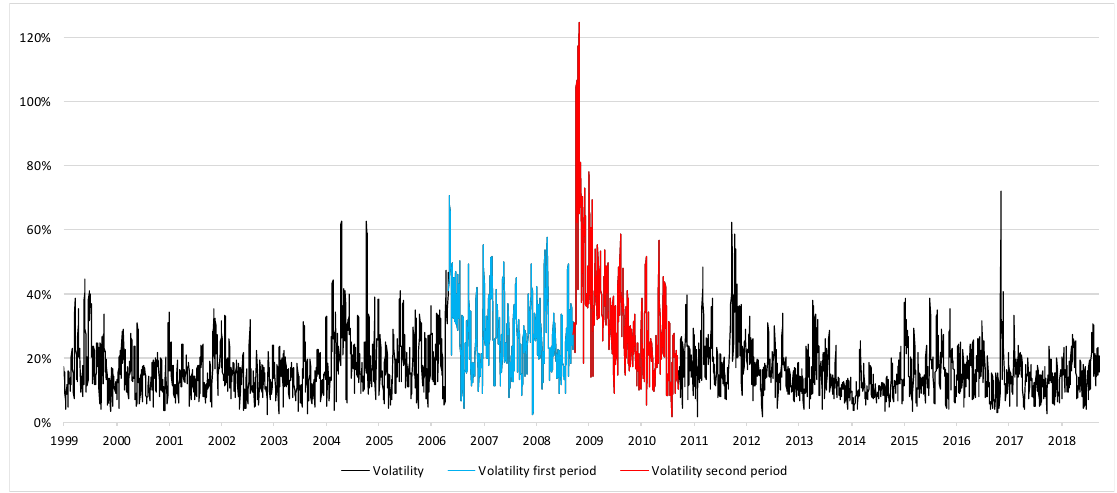
Figure 1. Five-day rolling window copper return annualized volatility from 1999 to 2018.